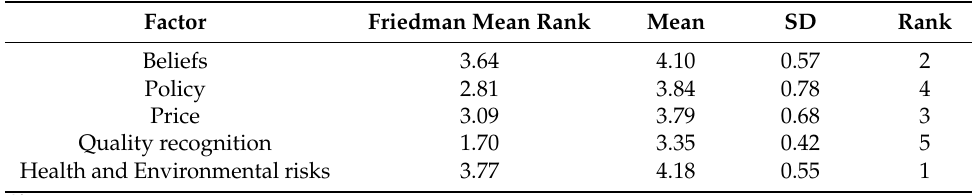
Table 4. Ranking extracted factors of the drivers for fraudulent pesticides.